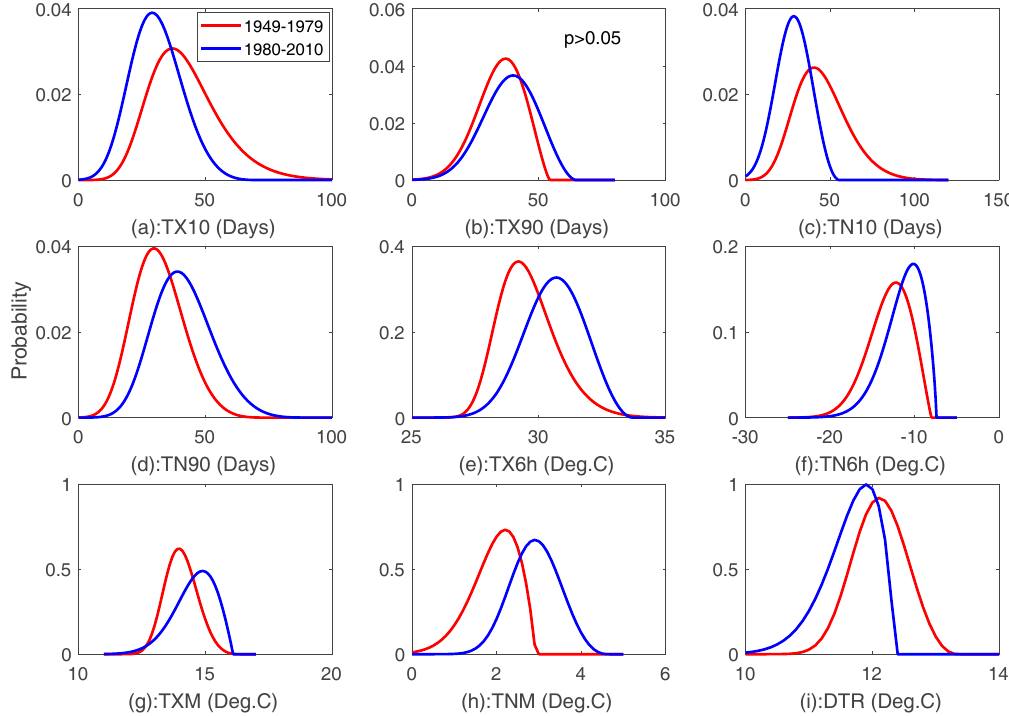
Figure 7. Probability Distribution Functions of nine temperature indices ( a ) TX10, ( b ) TX90, ( c ) TN10, ( d ) TN90, ( e ) TX6h, ( f ) TN6h, ( g ) TXM, ( h ) TNM, and ( i ) DTR in two sub-periods: water year 1949–1979 (red line) and 1980–2010 (blue line) for the Tulare region (TUL).